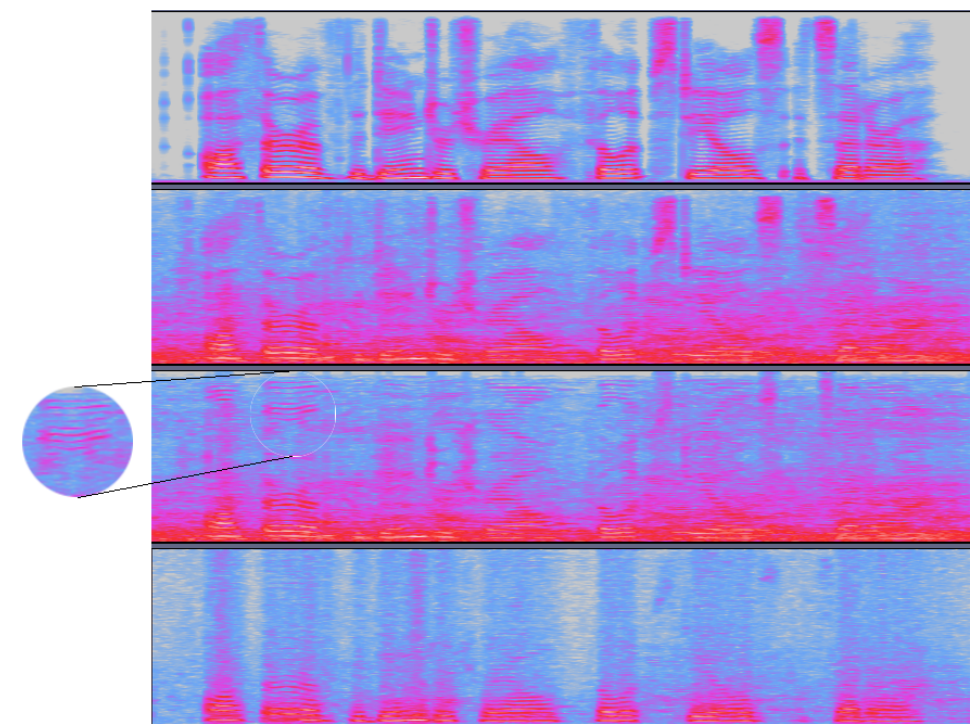
Figure 6. Spectrograms with results of the enhancement process. First row: clear utterance. Second row: noisy utterance, with Babble SNR 0. Third row: wavelet enhancement. Fourth row: hybrid wavelet+deep learning